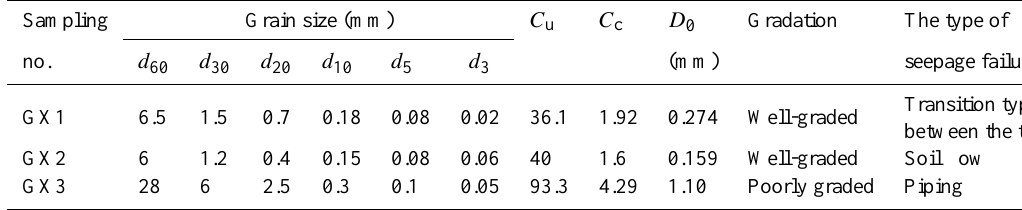
Table 1. The grain size distribution of moraines and possible types of seepage failure (Liu et al., 2013). Sampling